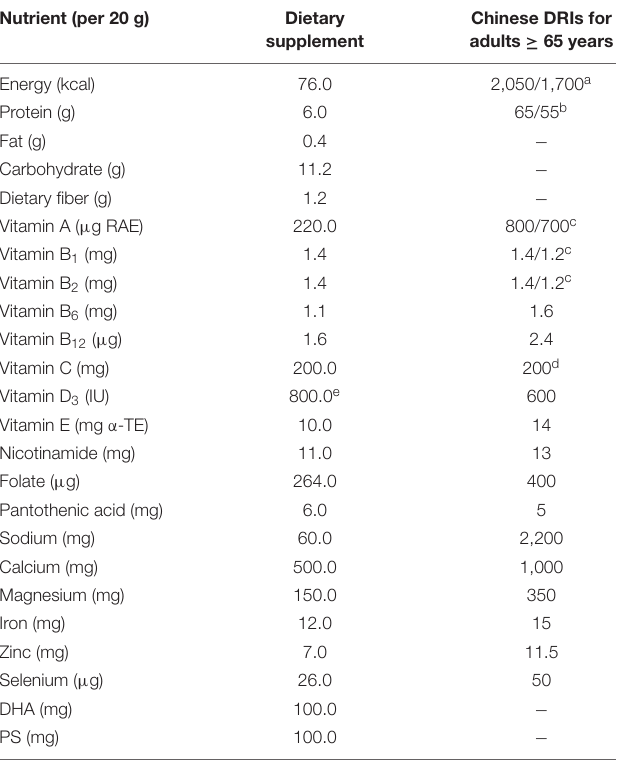
TABLE 1 | Composition of the dietary supplement customized for older adults (20 g per package per